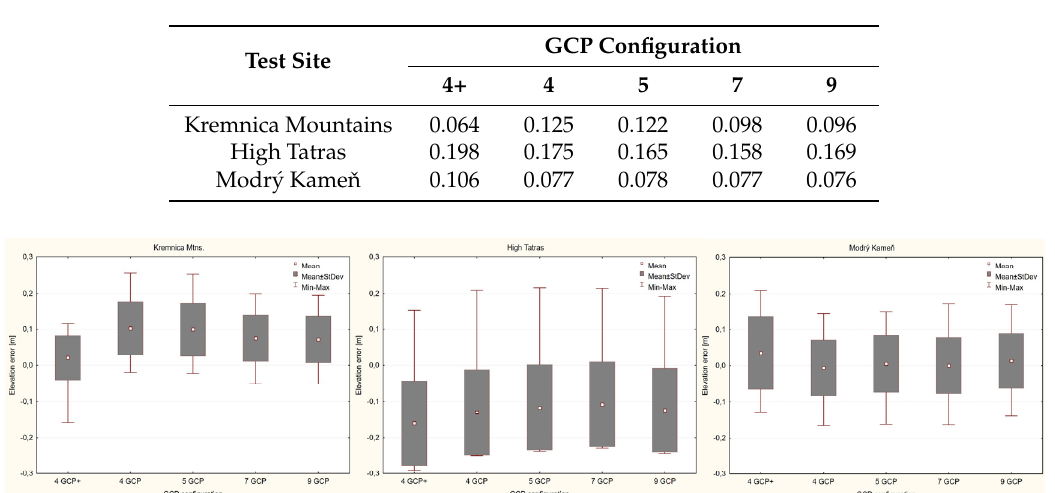
Figure 6. Minima, maxima, means, and standard deviations of the elevation errors Δ z according to the test sites and GCP configurations.